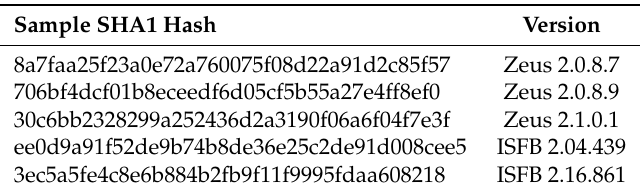
Table 1. Malware Sample Details.